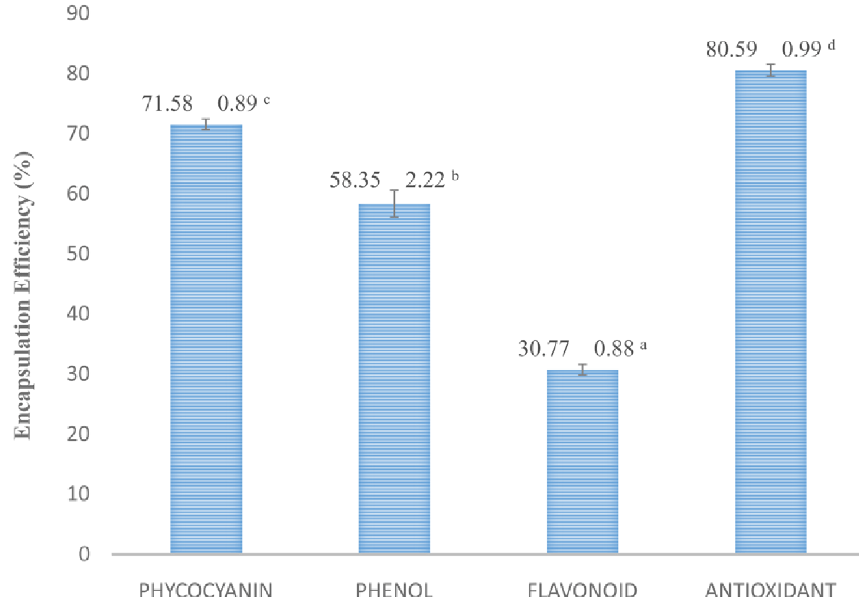
Figure 4. Encapsulation efficiency. (n=3, mean value ± standard deviation; different superscripts indicate a significant